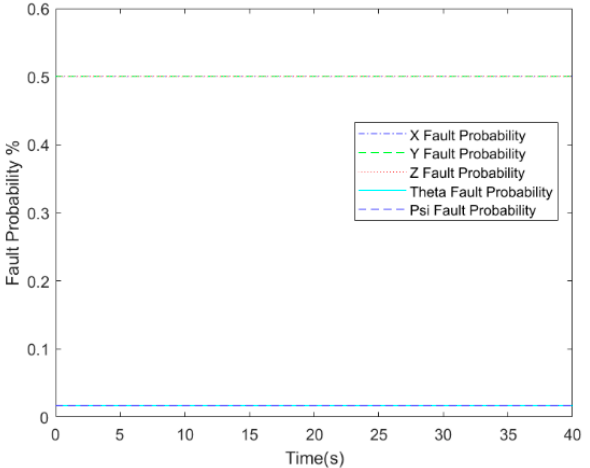
Figure 6. Bayesian fault probability (no fault). (b) Theta Angle Sensor